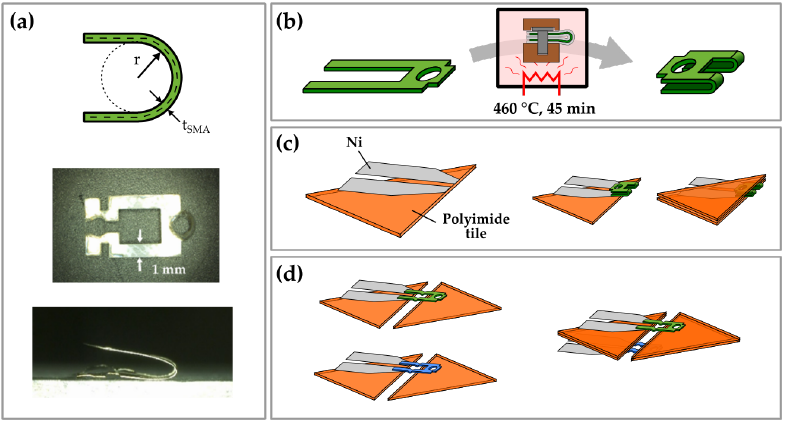
Figure 4. Fabrication and assembly of the folding microactuators: ( a ) microscope images of the micromachined NiTi foil before and after shape setting. ( b ) Schematic of laser micromachining and shape setting in a vacuum oven and ( c ) of electrical connection by gap welding and bonding to tiles. ( d ) Schematic of combining a protagonist and an antagonist microactuator for bi-directional folding.